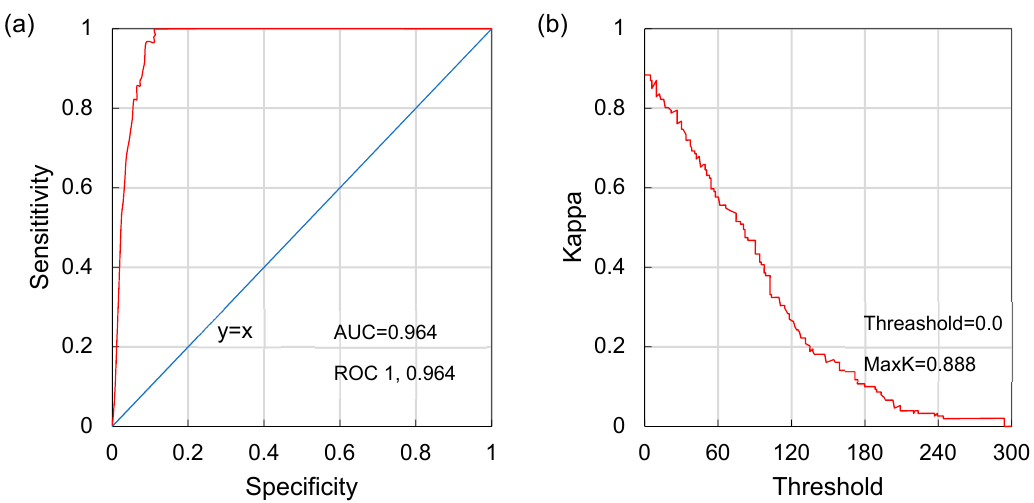
Figure 6. Prediction validation by ( a ) ROC and ( b ) kappa for BIOCLIM.